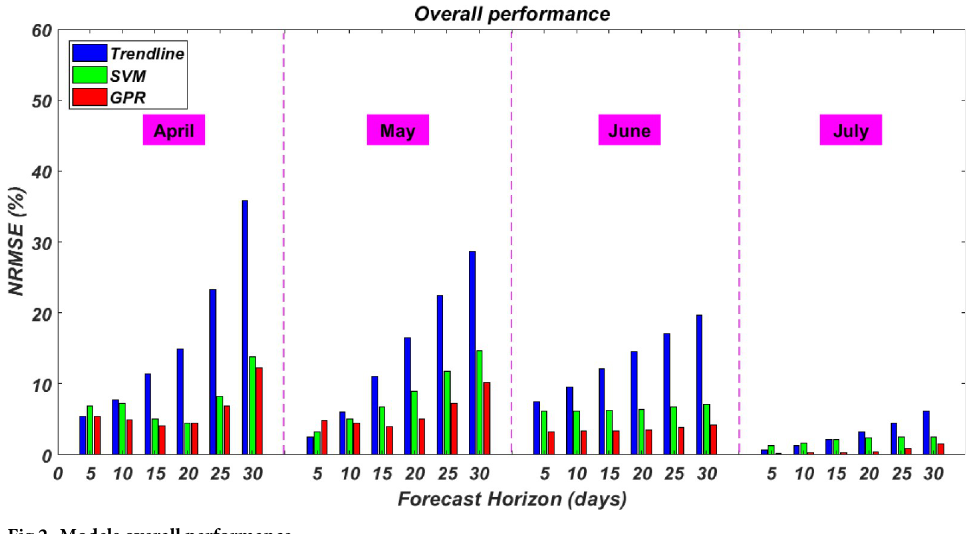
Fig 2. Models overall